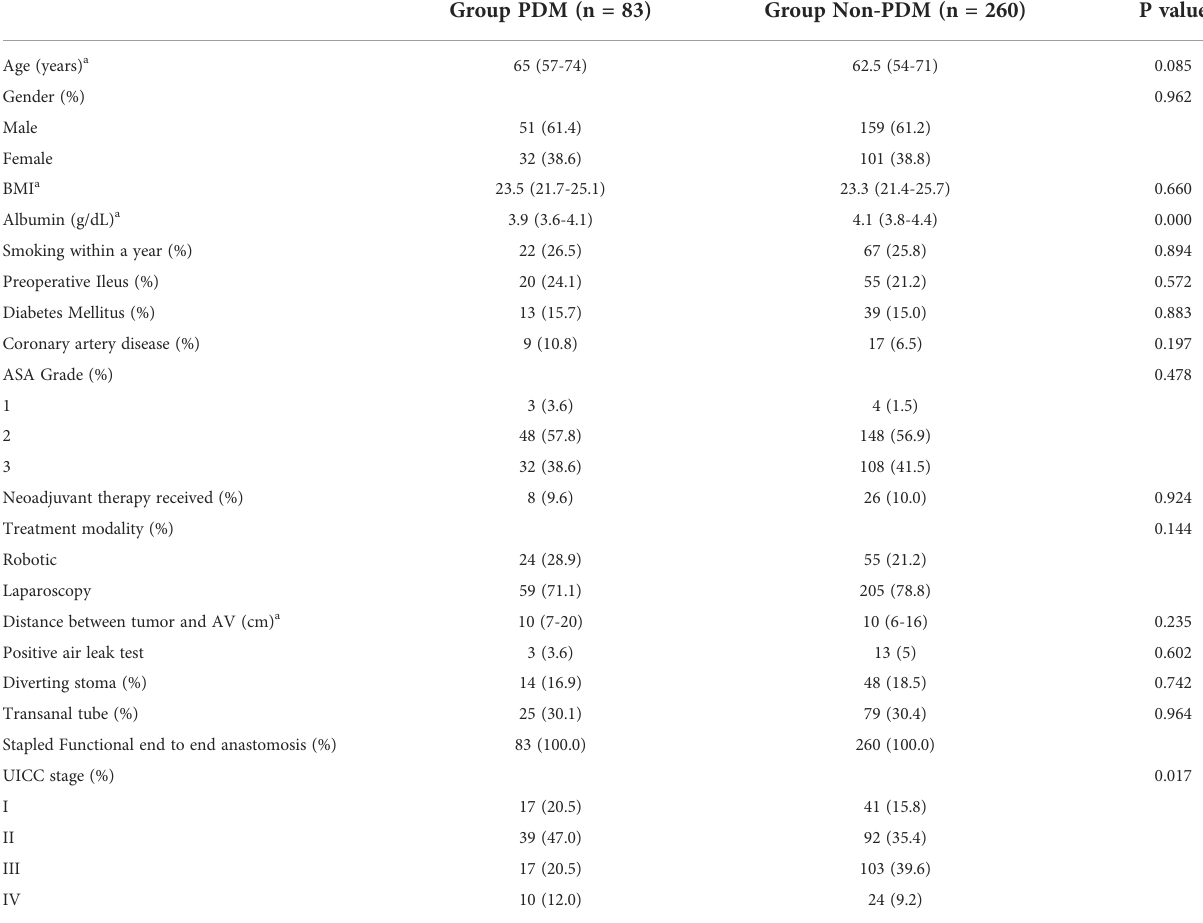
TABLE 1 Baseline characteristics and tumor locations before propensity score